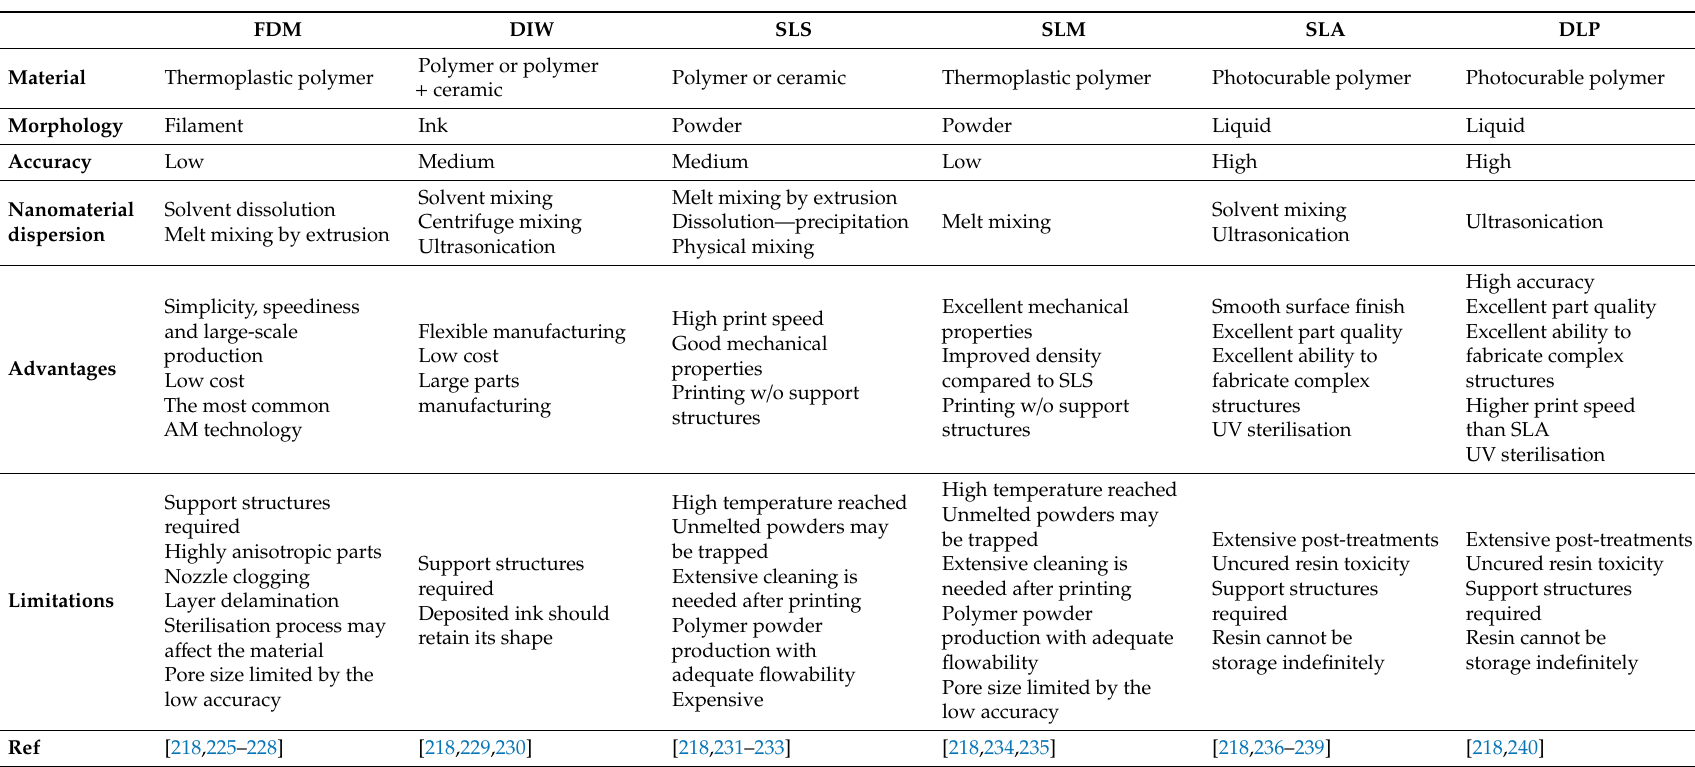
Table 2. Comparison of technologies of additive manufacturing available for biodegradable materials with nanomaterials. FDM DIW SLS SLM SLA